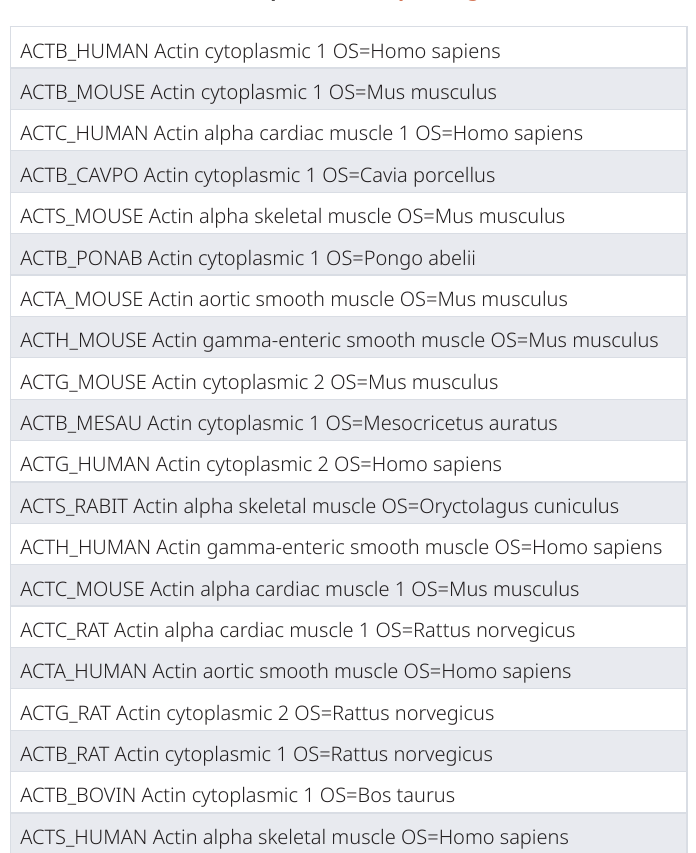
Table 4. Mammalian actin proteins